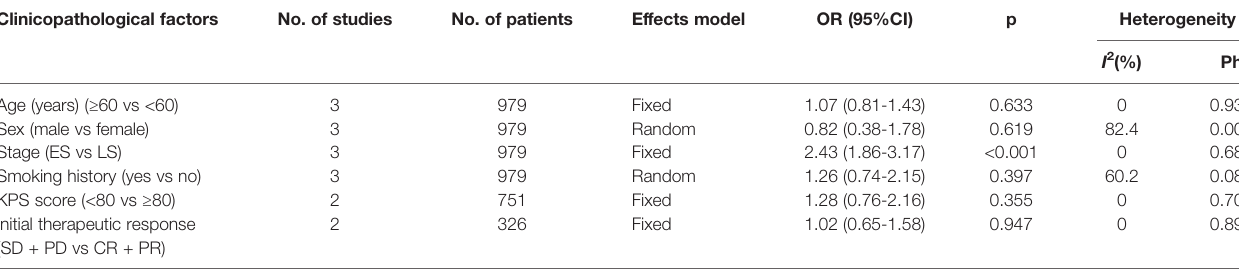
TABLE 4 | The correlation between SII and clinicopathological features in patients with SCLC. Clinicopathological